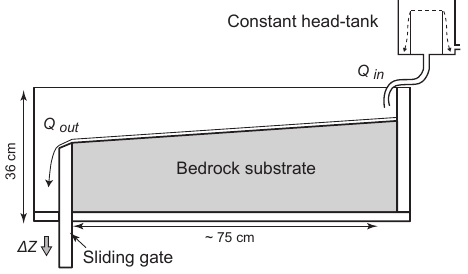
Figure 2. Experimental setup. Base-level fall, of rate U , is pro- duced by lowering the sliding gate. Q in is the water discharge in- troduced the flume using a constant head tank. Q out is the water discharge measured at the outlet of the flume. Because of absorp- tion by the substrate, Q in (1250mLmin − 1 ) is superior to Q out in every experiment (see Table